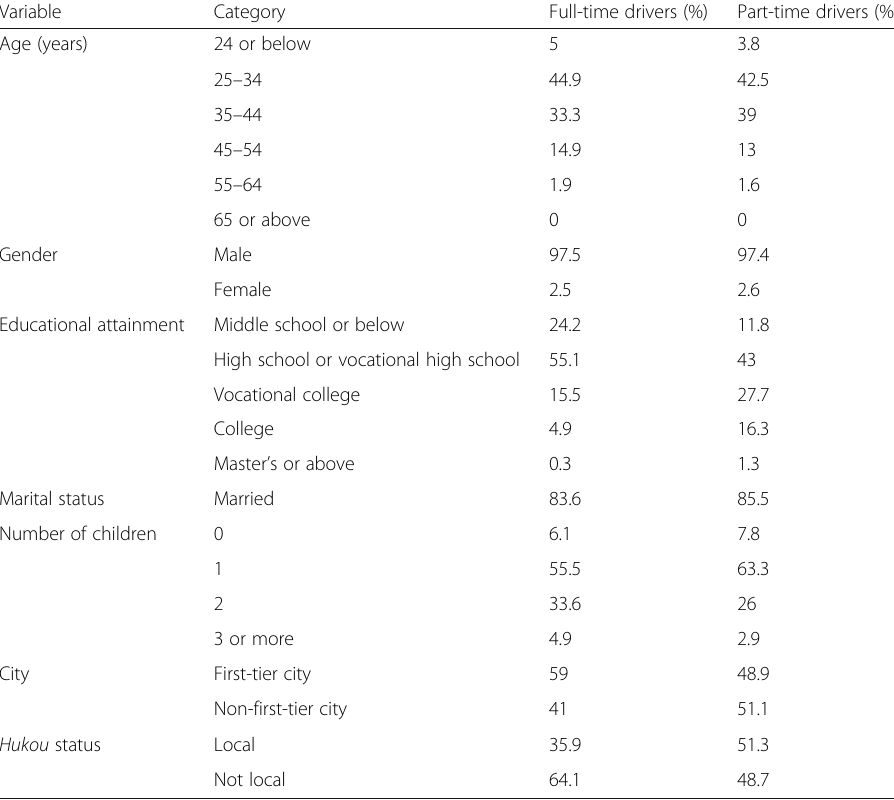
Table 2 Demographics of full-time and part-time drivers on Platform W Variable Category Full-time drivers (%) Part-time drivers (%) Age (years) 24 or